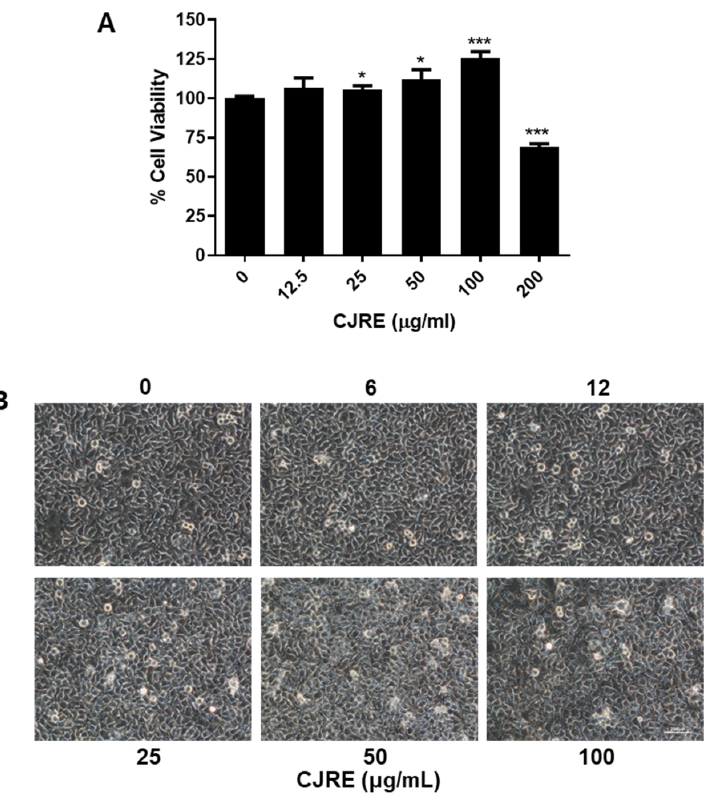
Figure 2. Cytotoxicity of CJRE on HeLa cells. ( A ). HeLa cells were treated with different doses of CJRE for 24 h and the cytotoxicity was measured using MTT assay. ( B ). HeLa cells were imaged under brightfield microscopy after treatment with different doses for 24 h. Scale bar, 250 µm; * p < 0.05; *** p < 0.0001.